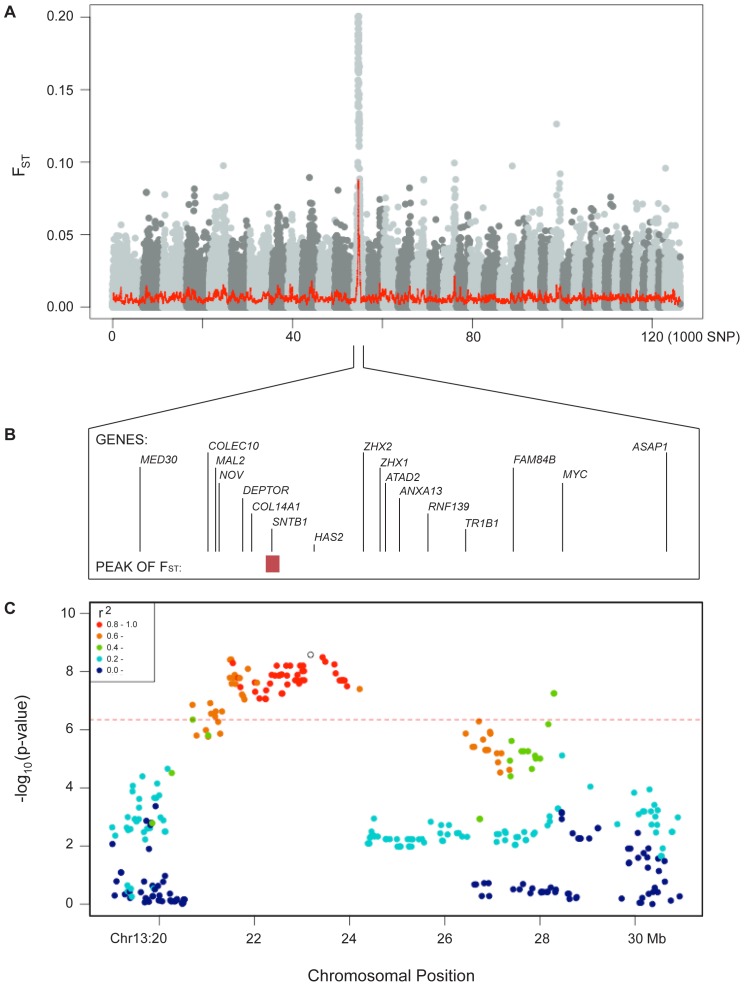
The genetic signature of within breed sub-type on chromosome 13.Individuals representing the extremes of physical appearance (Meatmouth, heavily wrinkled thickened skin, n = 123; Bonemouth, few wrinkles left into adulthood, n = 33) were compared. A. Pairwise F
ST was calculated between the two groups for 126,206 SNP and plotted in chromosomal order. Smoothed values in bins of 100 SNP are superimposed to better illustrate the peak of association (red line). B. A zoomed view of a subset of the genes from the chromosome region in relation to the peak of F
ST (based on most divergent SNP and a 5% threshold, red box). C. The plot of a mixed model association test for breed subtype. The top genome-wide significant SNP (13∶23180227, pMM = 2.63×10−9) has been highlighted with an open circle and linkage disequilibrium (r2) between this marker and the others in the region are coloured according to strength. A genome wide significant threshold (red dotted line) has been defined using an analysis specific Bonferroni 5% limit.